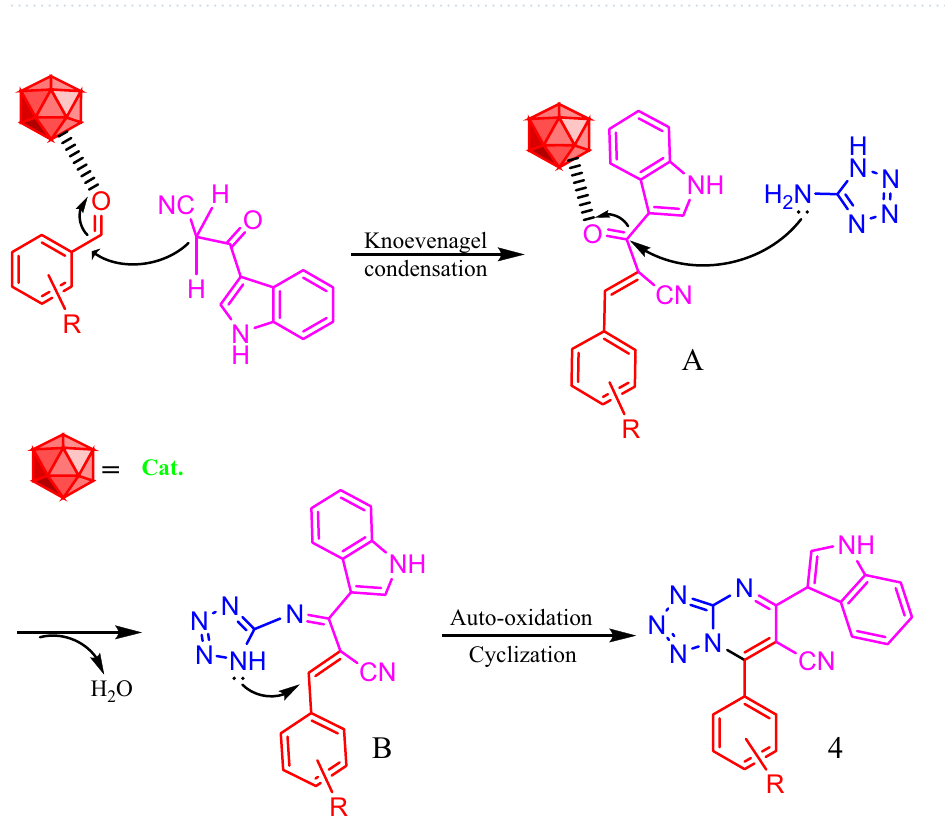
Table 5. Comparison of the present methodology for the synthesis of tetrazolo[1,5-a]pyrimidine-6- carbonitrile 4c with the reported method. a Isolated